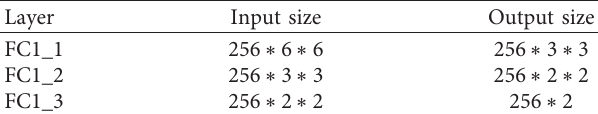
Table 2: The structure of fusion attention module. Table 3: The structure of FC1 in Figure 5.